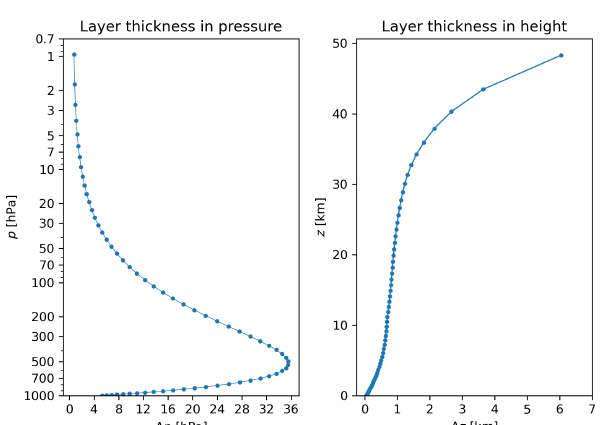
Figure 2. Vertical levels used in simulations. Layer thickness in pressure (cid:49)p/ height (cid:49)z as a function of pressure p/ height z for a US standard atmosphere with a surface pressure of